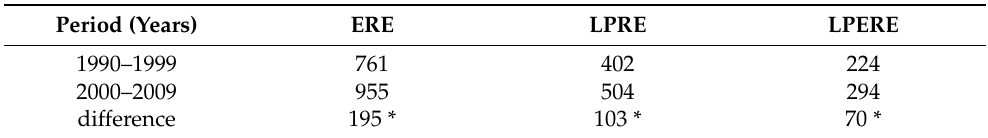
Table 2. As in Table 1, but for the numbers of EREs, LPREs, and LPEREs, as well as the associated differences between the two periods. The superscript “*” indicates that the differences are statistically significant at the 90% confidence level.